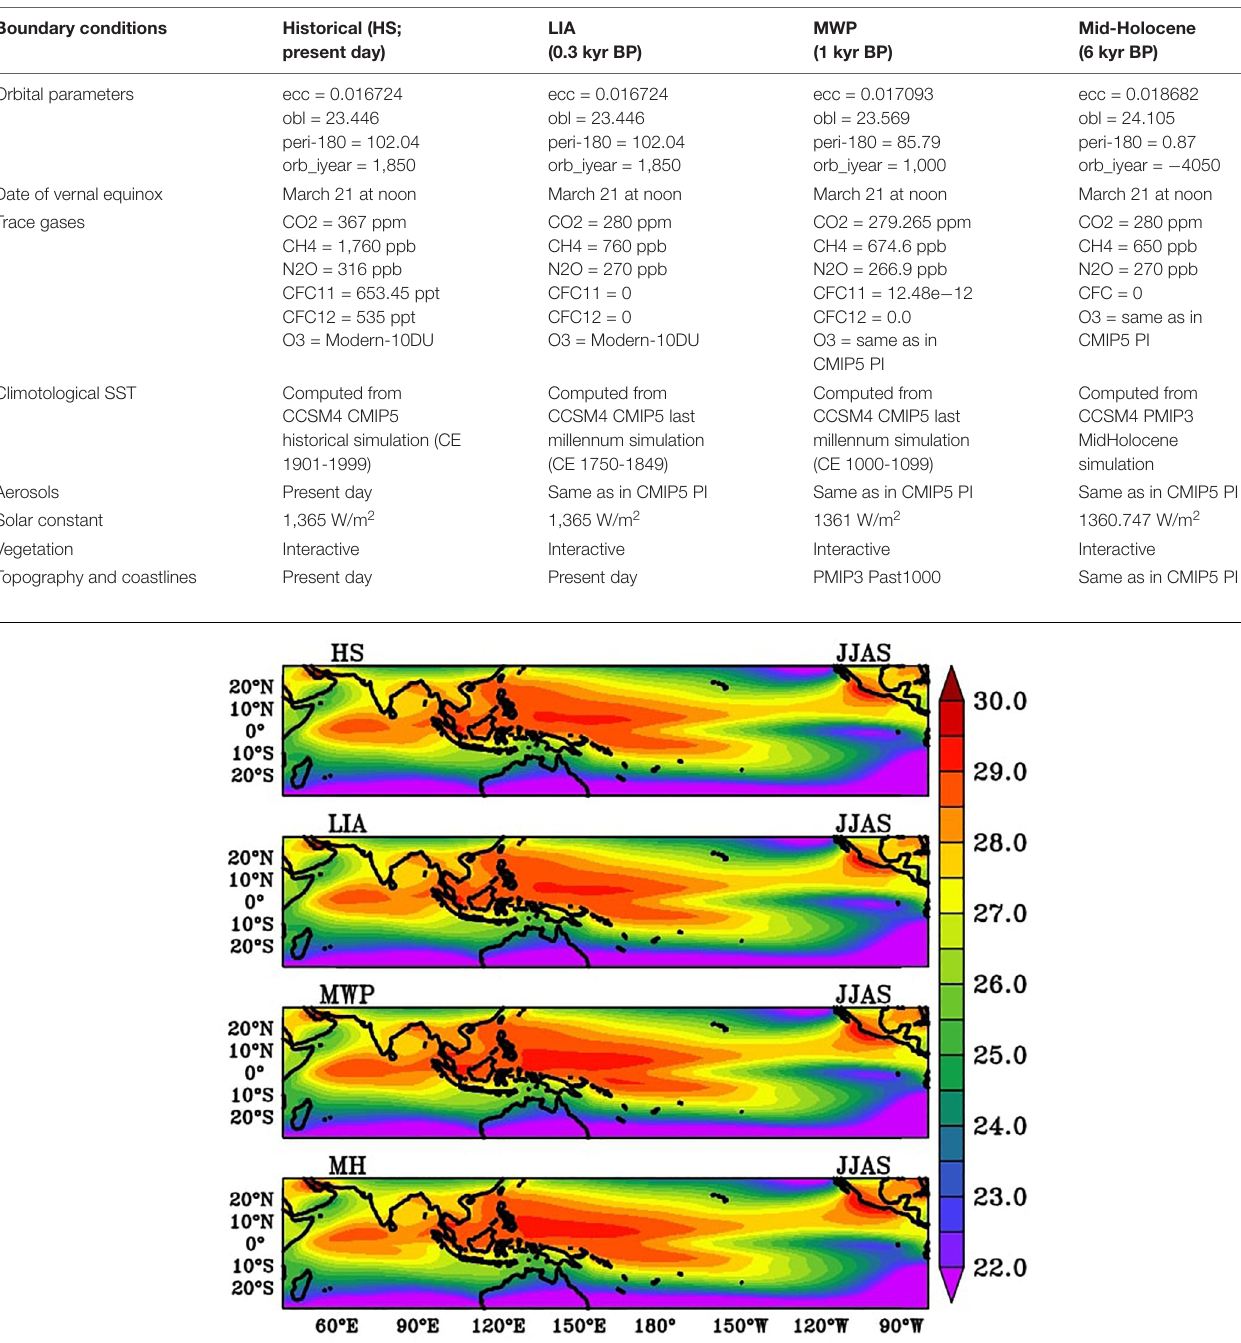
TABLE 1 | Summary of boundary conditions used in different climate periods.